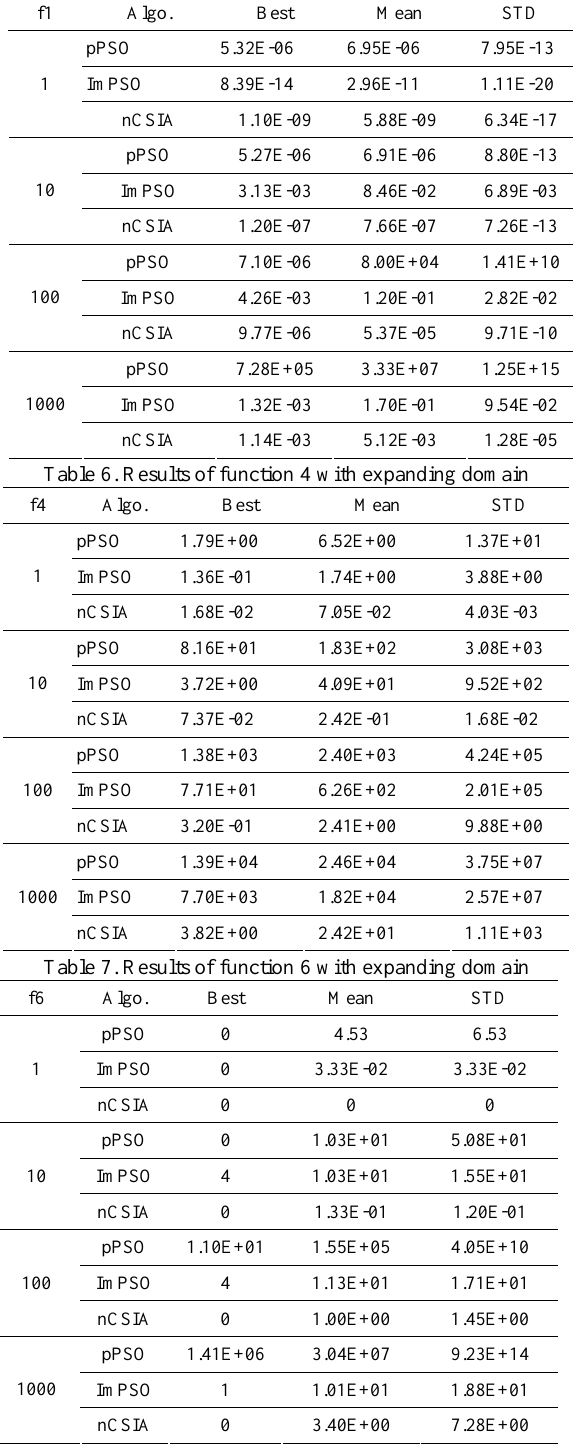
Table 6. Results of function 4 with expanding domain